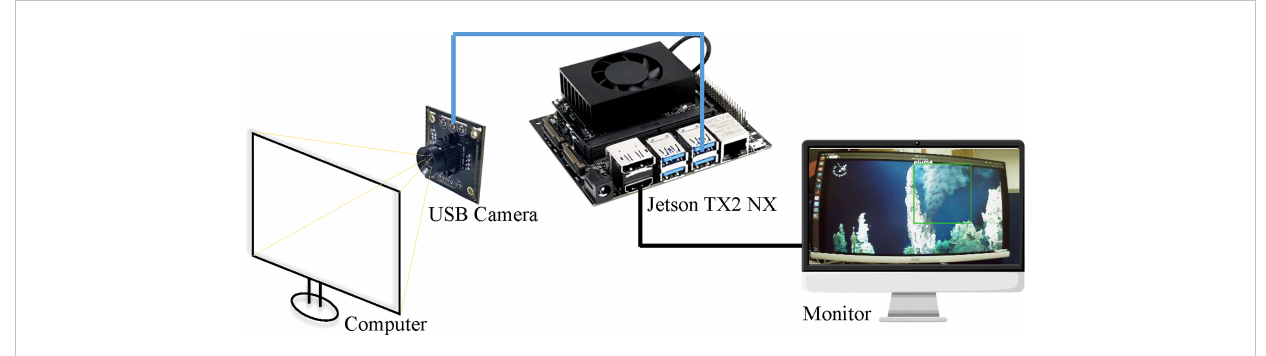
FIGURE 9 Testing the proposed plume detector on Jetson TX2